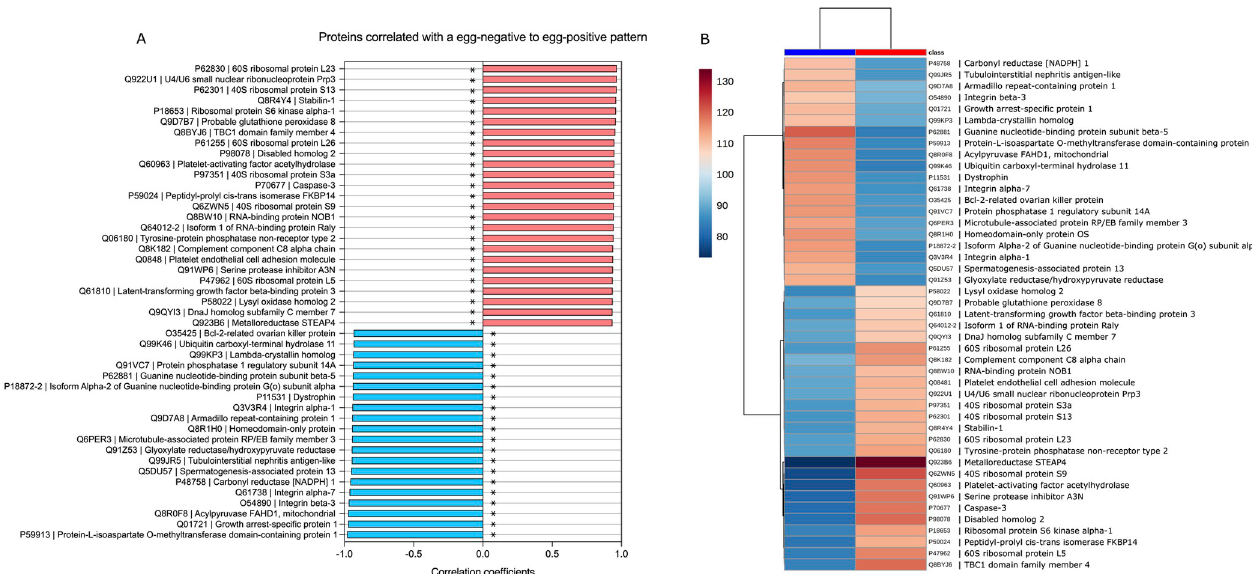
Fig 3. a) Pattern correlation analysis of the 45 proteins (DEPs), showing increasing and decreasing patterns relative to S . haematobium egg status. Correlation coefficients indicate correlation pattern or protein abundance trends relative to the S . haematobium egg injection group. Pink and blue bars indicate a positive and negative correlation with S . haematobium egg-injection respectively. � , raw p < 0.001 and FDR < 0.05. b) Clustering and heatmap of significantly differentially expressed proteins among the S . haematobium egg-injection group (cases) and the tissue extract-injection group (controls). The heat map was created based on the mean relative abundance of the 45 significant differentially expressed proteins (distance measure using Euclidean, clustering algorithm– Ward’s linkage). Red class label indicates the case group, and the blue class label represents the control group.